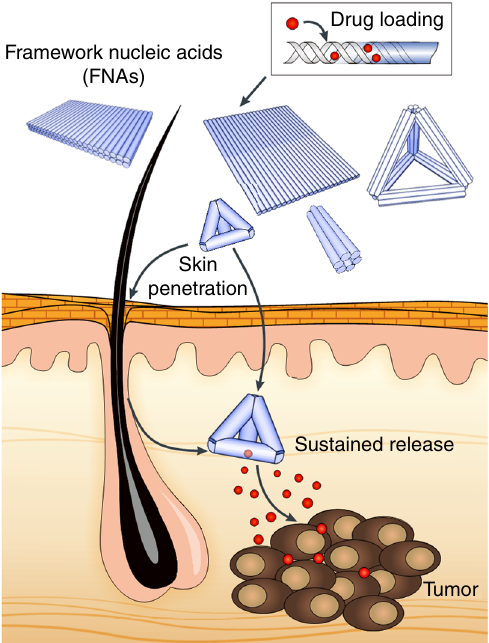
Fig. 1 Schematic representation of the topical application of framework nucleic acids (FNA) for transdermal drug delivery. Upon successful penetration, FNAs can release conjugated/intercalated drugs, including but not limited to melanoma